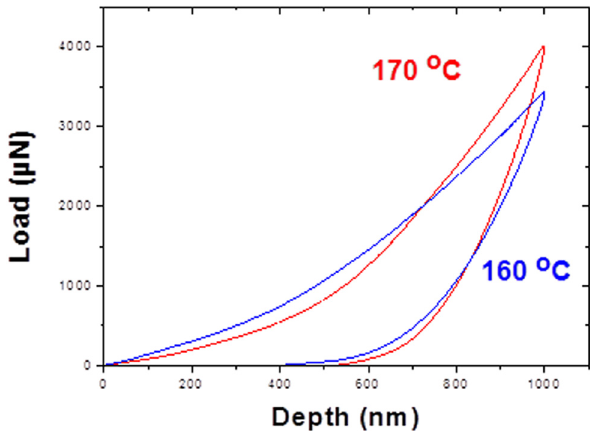
Figure 3: Nanoindentation load – displacement curves for Arboblend V2 Nature samples made at 160 and 170°C.